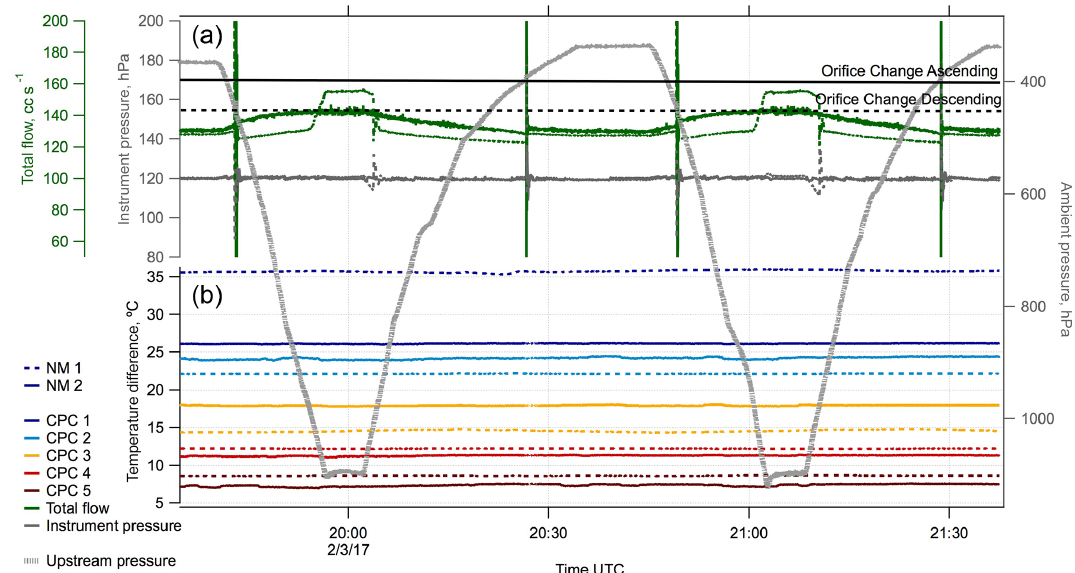
Figure 11. Flows, temperatures, and pressures measured by both NMASSs over the total course of an ATom flight. Ambient pressure is shown in grey, coloured lines in panel (b) are the temperature difference between condenser and saturator in each of the CPCs. Panel (a) shows the total NMASS flow (green) and instrument pressure (dark grey). Solid lines are used for NMASS 2, dashed lines for NMASS 1. Ambient pressures at which the orifice is changed are shown by the black horizontal lines. This occurs at 400hPa on ascent (solid line) and 450hPa on descent (dashed line). The spikes in instrument pressure and total flow are a response to the orifice change. At inlet pressures > 960hPa, NMASS-1 total flows could not be maintained with acceptable limits in ATom-1 and ATom-2; this has been fixed for subsequent